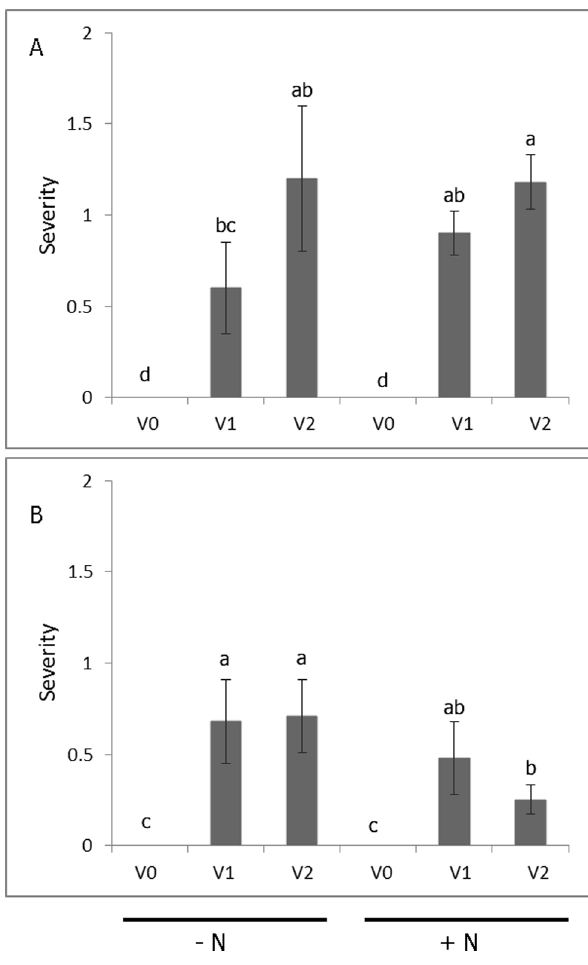
Figure 2. Virus symptom severity ratings of plants from the first (A) and second (B) experiments. Virus symptom severity was assessed the day before each experiment was terminated by rating each leaf by visual estimation of the proportion of the leaf showing symptoms using a 0 to 3 scale in which: 0= no symptoms, 1= , 1/3 of the leaf involved, 2=1/3–2/3 of leaf area involved, and 3= . 2/3 of the leaf involved. + N = nitrogen provided as KNO 3 , - N=no nitrogen provided. V0 = plants derived from non-inoculated, virus-tested plant stock; V1 = plants derived from V0 plant stock graft inoculated with the potyvirus complex (SPFMV, SPVG, SPVC, and SPV2); V2 = plants derived from plant stock infected with SPCSV. Severity ratings were transformed using log 10 and Fisher’s LSD test at the 0.05 probability level was used to test for statistical significance. The data are expressed as means 6 SE from non-transformed